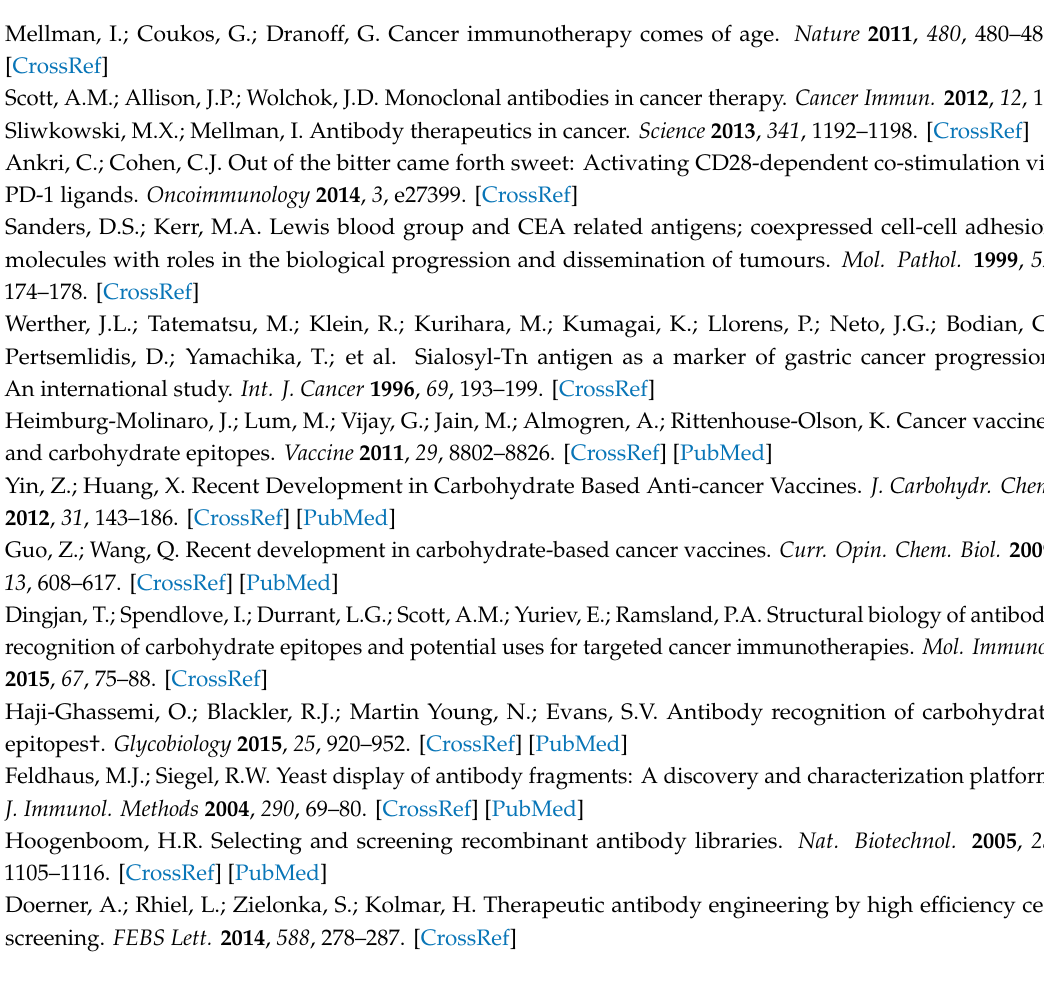
Figure S1: Gibson assembly of variable regions into p3BNC IgG expression vectors, Table S1: list of glycans nanoprinted on glycan microarrays, Table S2: list of